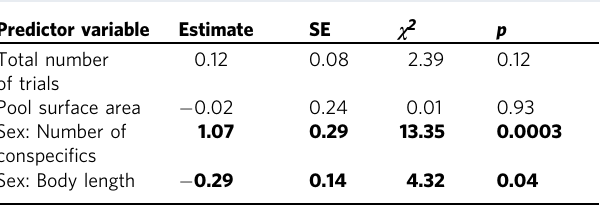
Table 4 Generalized linear mixed model summary for total bites taken per